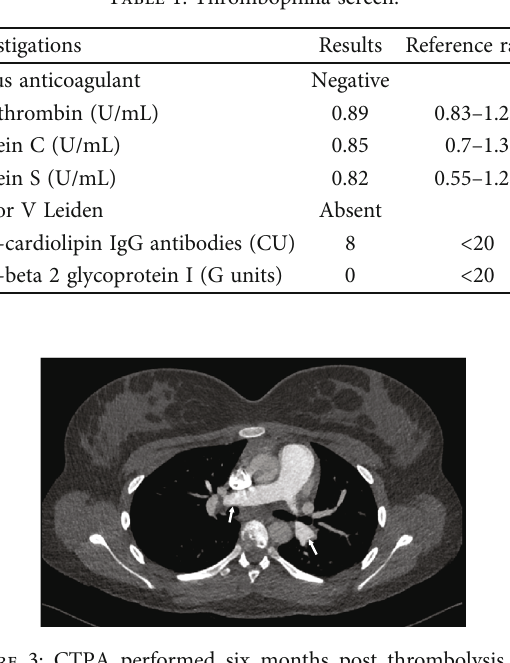
Figure 2: CTPA performed four days post thrombolysis with reduction of pulmonary embolism (arrows). Table 1: Thrombophilia screen.